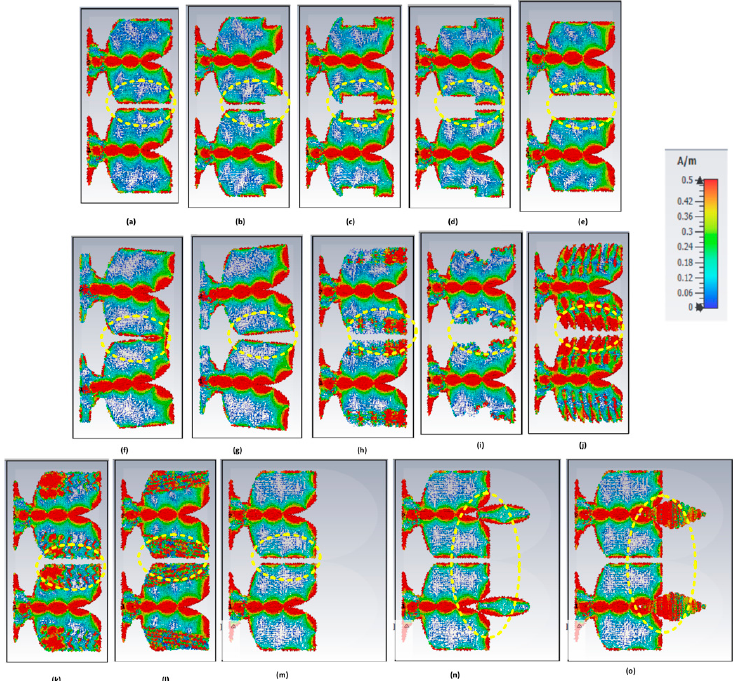
Figure 13. Surface current performance of ( a ) Regular Palm Tree (RPT-CVA), ( b ) Front Cut Palm Tree (FCPT-CVA), ( c ) Middle Cut Palm Tree (MCPT-CVA), ( d ) Back Cut Palm Tree (BCPT-CVA), ( e ) Complete Cut Palm Tree (CCPT-CVA), ( f ) Left Tilt Palm Tree (LTPT-CVA), ( g ) Right Tilt Palm Tree (RTPT-CVA), ( h ) Hilbert Fractal Structure Palm Tree (HFSPT-CVA), ( i ) Koch Fractal Structure Palm Tree (KFSPT-CVA), ( j ) Exponential Slot Edge Palm Tree (ESEPT-CVA), ( k ) Vertical Wave Structure Palm Tree (VWSPT-CVA), ( l ) Horizontale Wave Structure Palm Tree (HWSPT-CVA), ( m ) Regular Lens Palm Tree (RLPT-CVA), ( n ) Elips Lens Palm Tree (ELPT-CVA), and ( o ) Metamaterial Lens Palm Tree